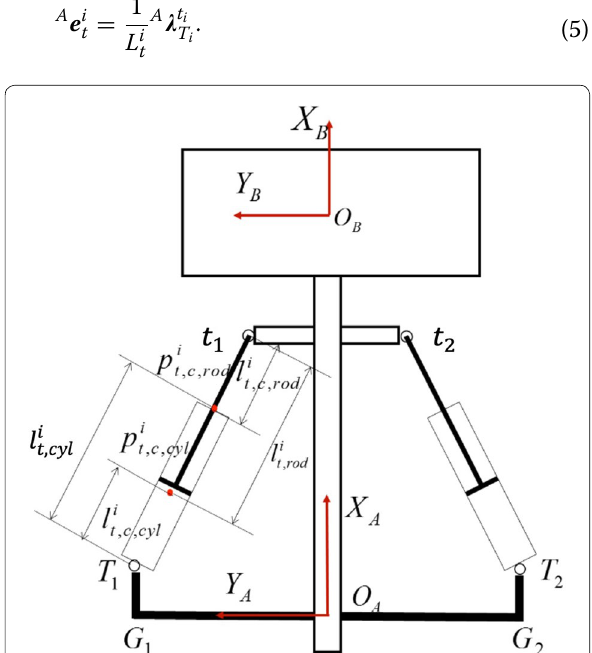
Figure 3 Structure of main parts of open type TBM Figure 4 Mechanical structure of thrust